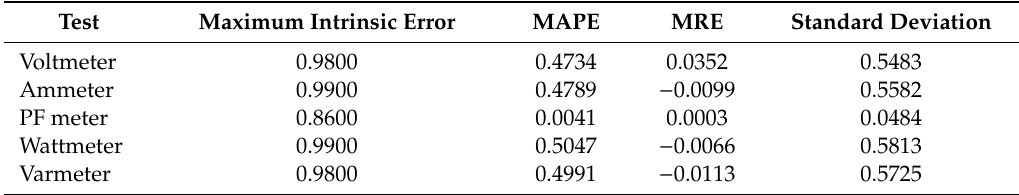
Table 13. Continuous overload test: maximum intrinsic error (%), MAPE (%), MRE (%), and standard deviation (%).